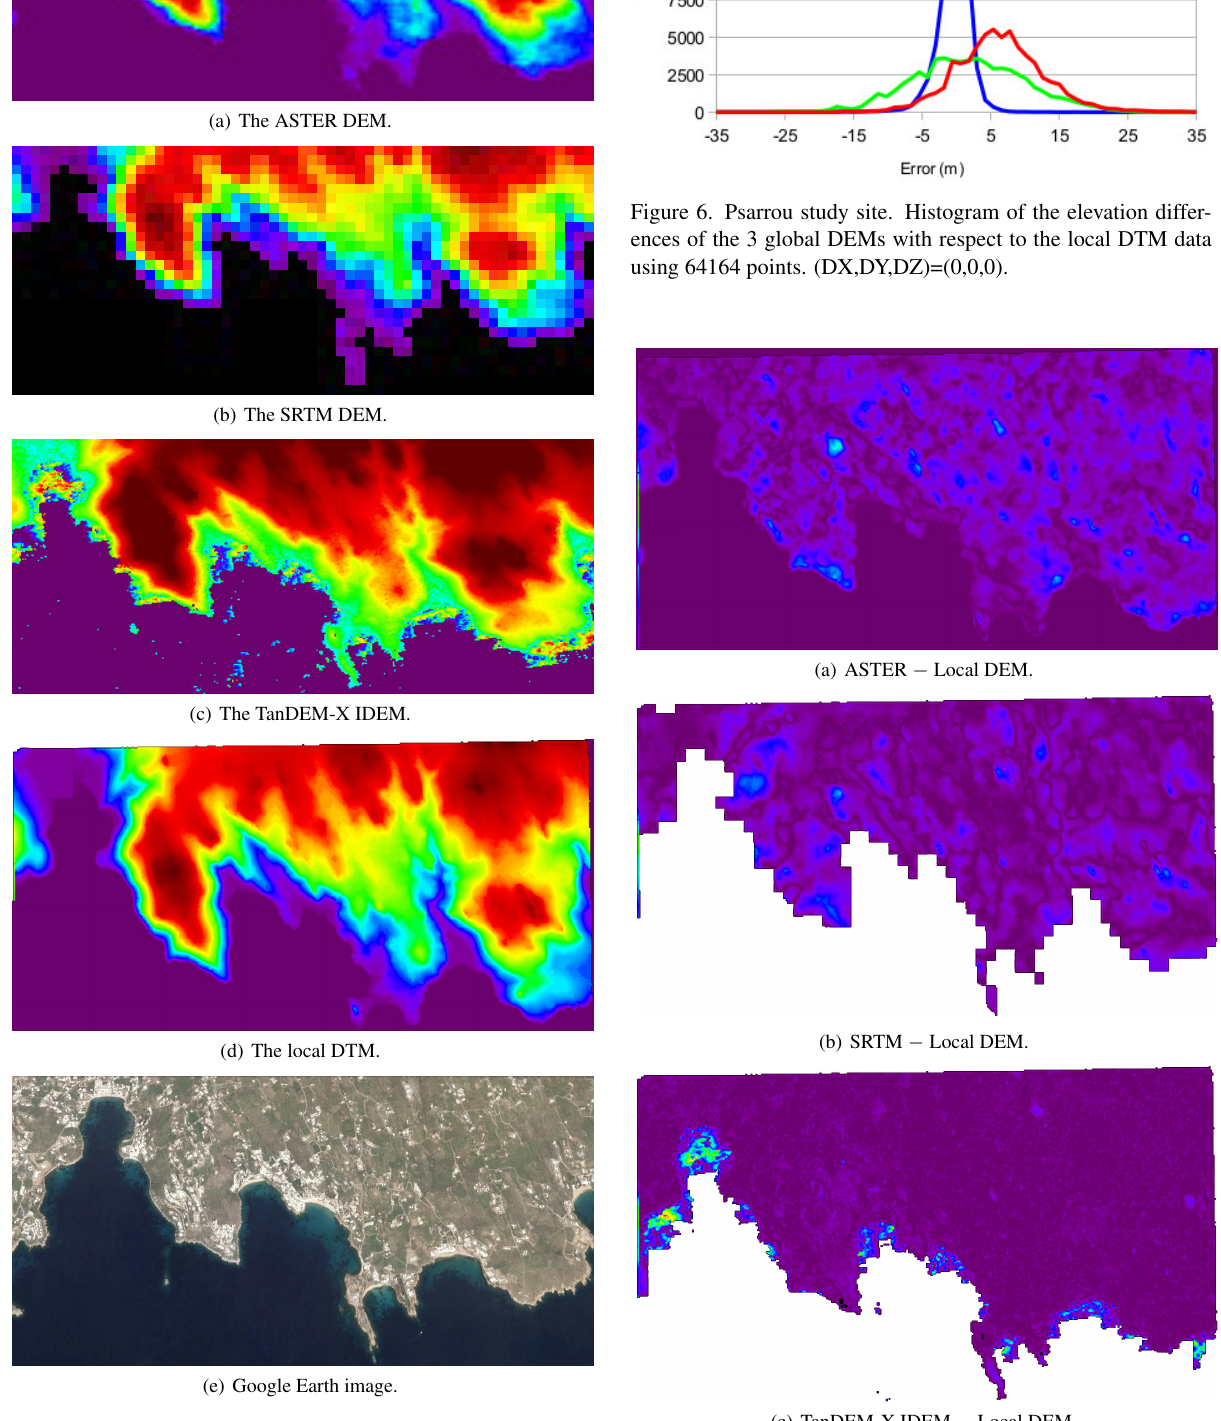
Figure 5. The Psarrou study site in the Mykonos island.